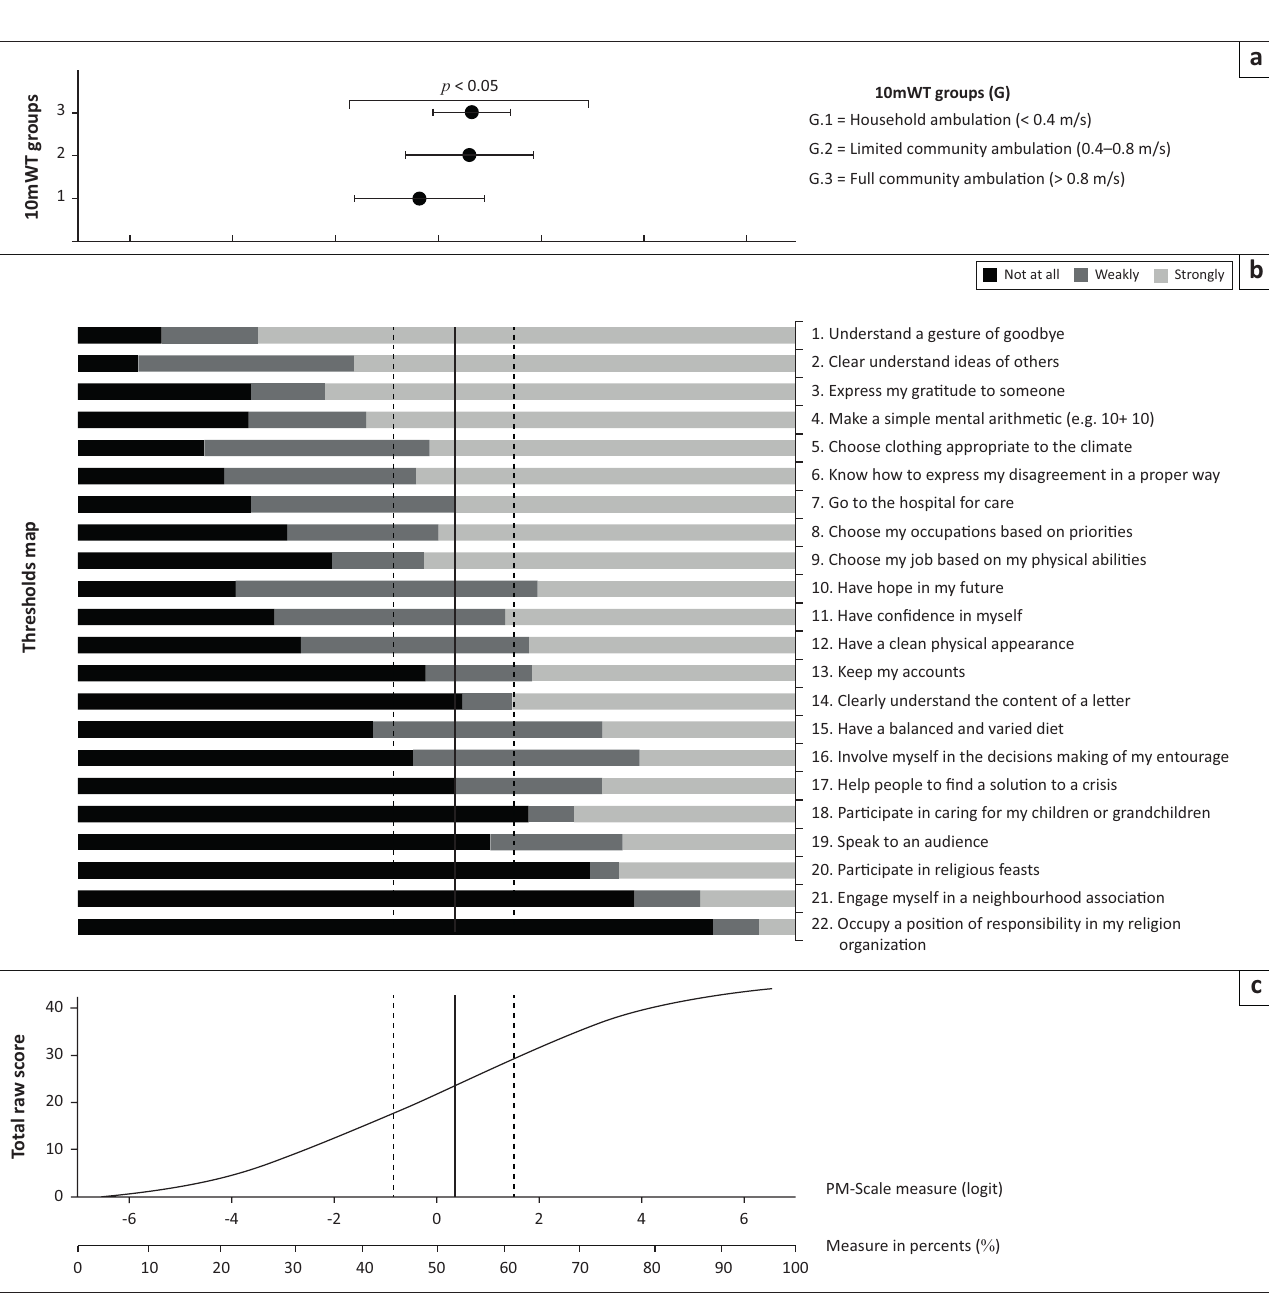
FIGURE 4: Graph showing social participation